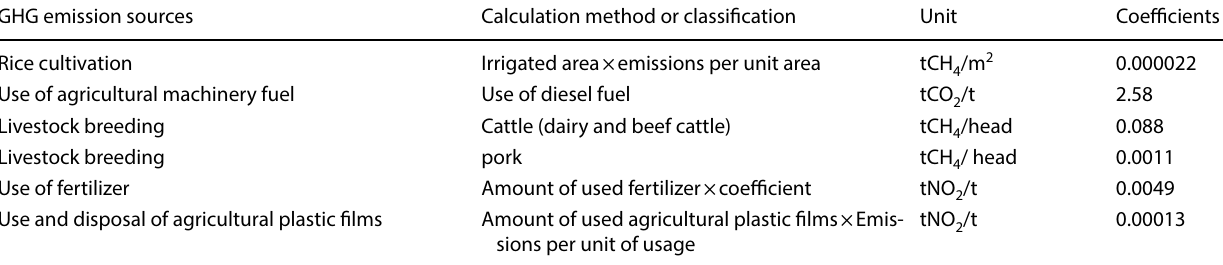
Table 3 Calculation method of agricultural GHG emissions and emission coefficients